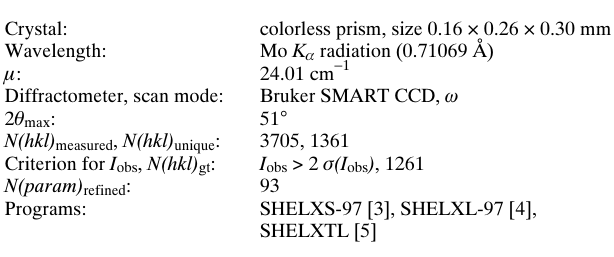
Table 1. Datacollection and handling.